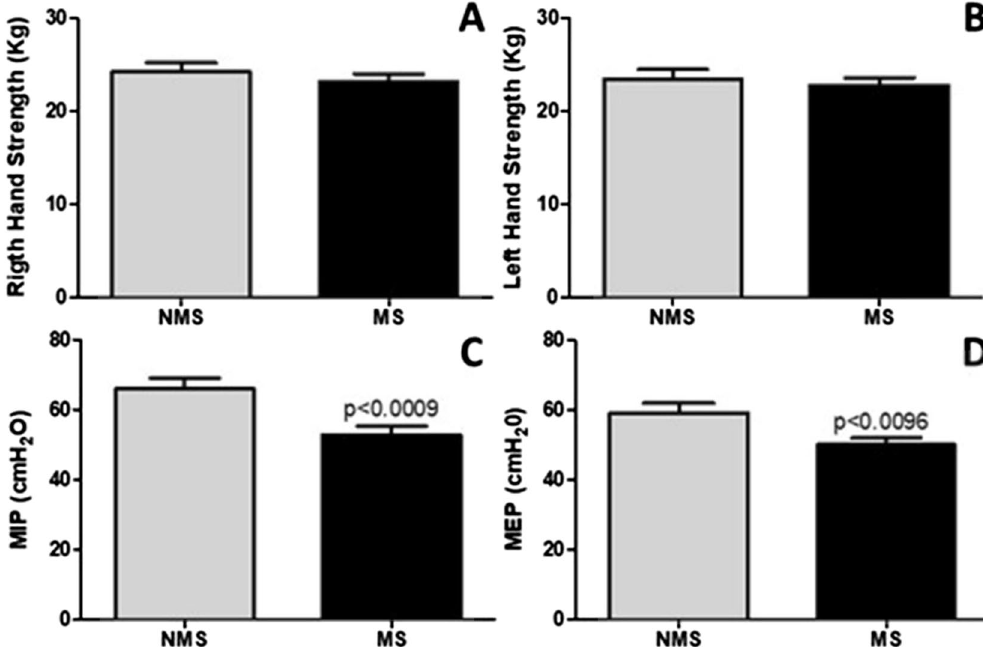
Figure 5. General strength measured by hand grip strength and respiratory muscle strength measured by manovacuometer in older adults with and without metabolic syndrome MS. Figure 5A (Right hand grip strength), Figure 5B (Left hand grip strength), Figure 5C (Maximal inspiratory pressure – MIP), Figure 5D (Maximal expiratory pressure –